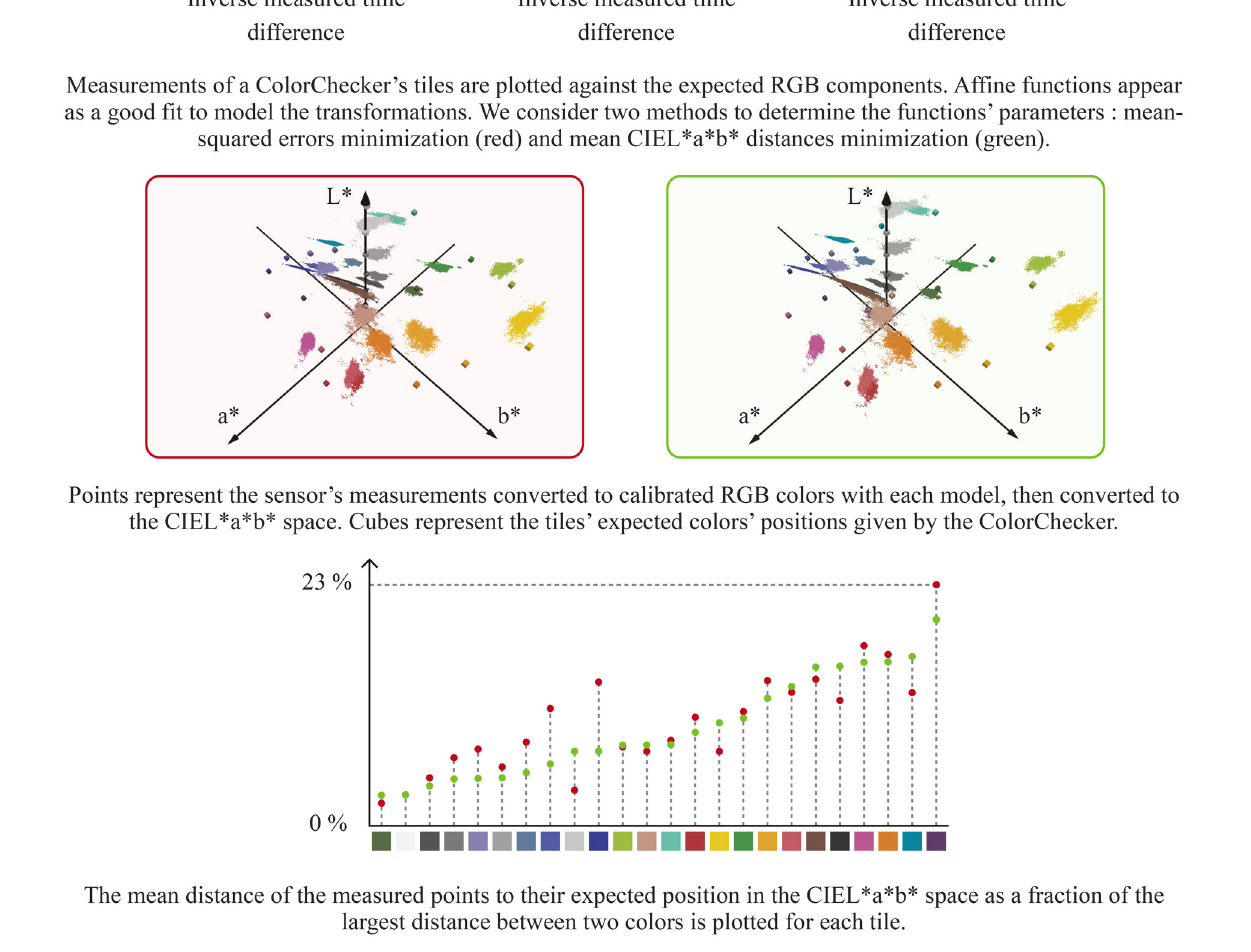
FIGURE 5 | Converting the sensor’s color events to the CIEL*a*b* space requires a transformation model. We use a Macbeth ColorChecker to compare the expected color values with the measured time differences. We consider two strategies for finding our model’s parameters : mean squared error (red) and non-linear optimization to minimize the distance between expected and measured colors in the CIEL*a*b* space (green). The latter yields a better fit for blue and purple colors in the a*b* plane. On the a*b* plane figures, squares represent the expected colors and circles represent the mean measured value. The represented Macbeth ColorCheckers were captured by our